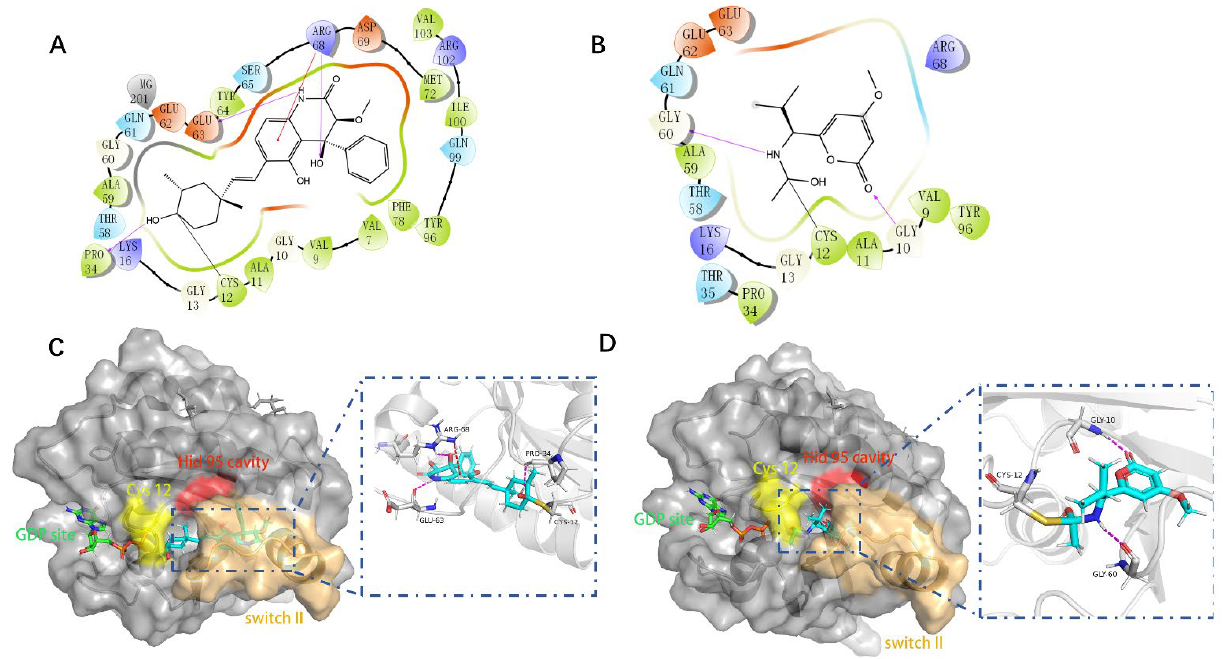
Figure 5. The most pharmaceutically available compound 44 with compound 14 and the KRAS G12C docking structure diagram. ( A ) Two-dimensional binding mode of compound 44 and protein complex; ( B ) two-dimensional binding mode of compound 14 and protein complex; ( C ) three-dimensional binding mode of compound 44 and protein complex; ( D ) three-dimensional binding modes of compound and protein complexes. The purple sticks are hydrogen bonds and the red sticks are ΠΠ cation interactions . Table 3. Docking RMSD between ligand pose and crystal coordinates for compounds with better docking results than positive controls.